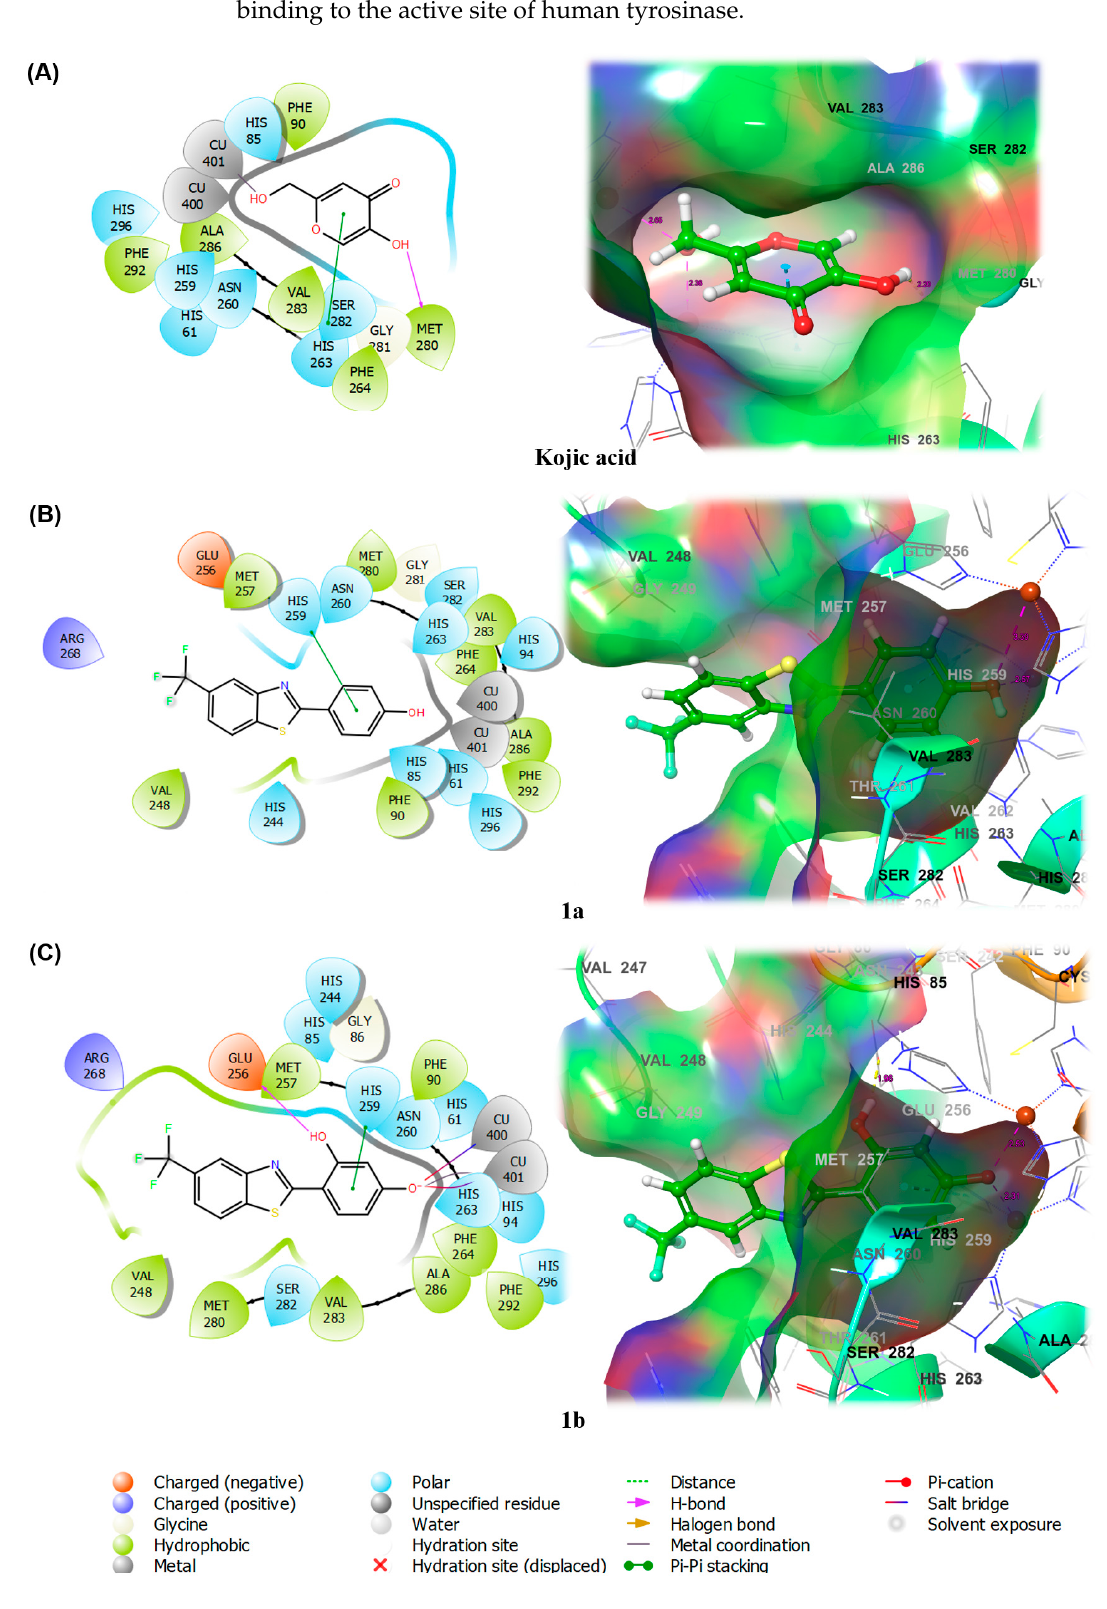
Figure 5. Binding interactions between mushroom tyrosinase (PDB ID = 2Y9X) and compounds 1a and 1b , and kojic acid.